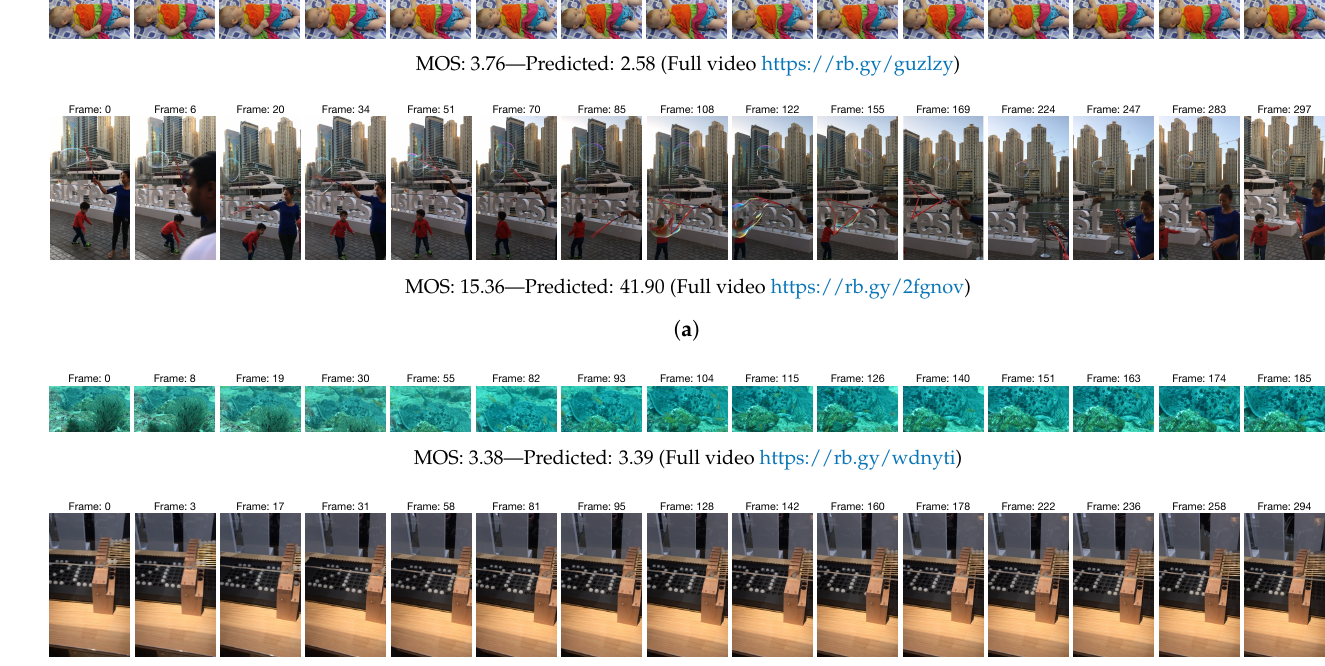
Figure 5. (Best viewed in colors and magnified.) Visualization of some examples of prediction of the proposed method. ( a ) Two samples of under- and overestimated video quality predictions. ( b ) Two videos with a very low error between the MOS and the predicted quality score. For each video, the 15 frames sampled by the proposed method, the MOS, and the quality score predicted by our method are shown.